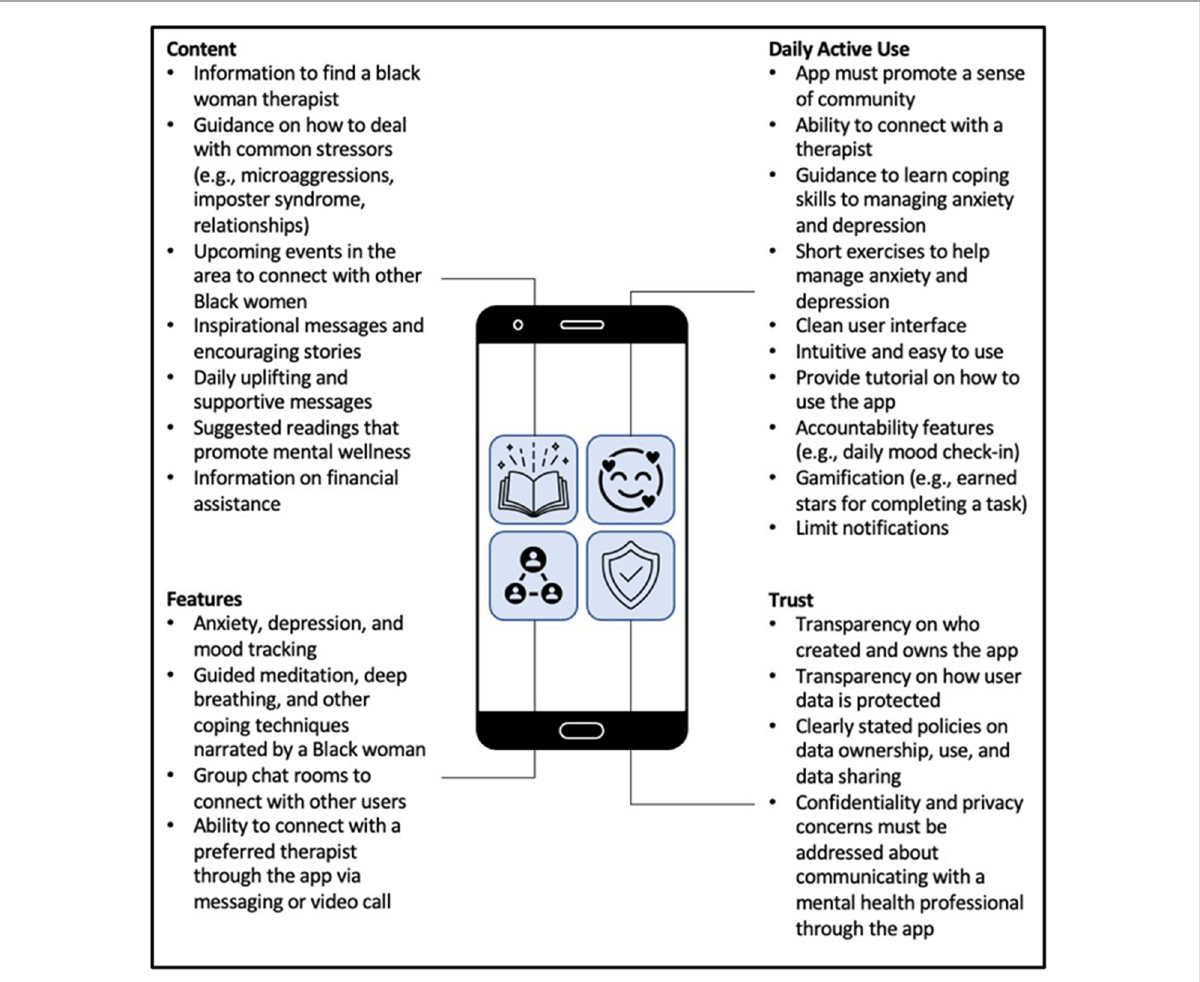
FIGURE 1 User-centered recommendations for the design of a mobile app to support management of anxiety and depression among Black American